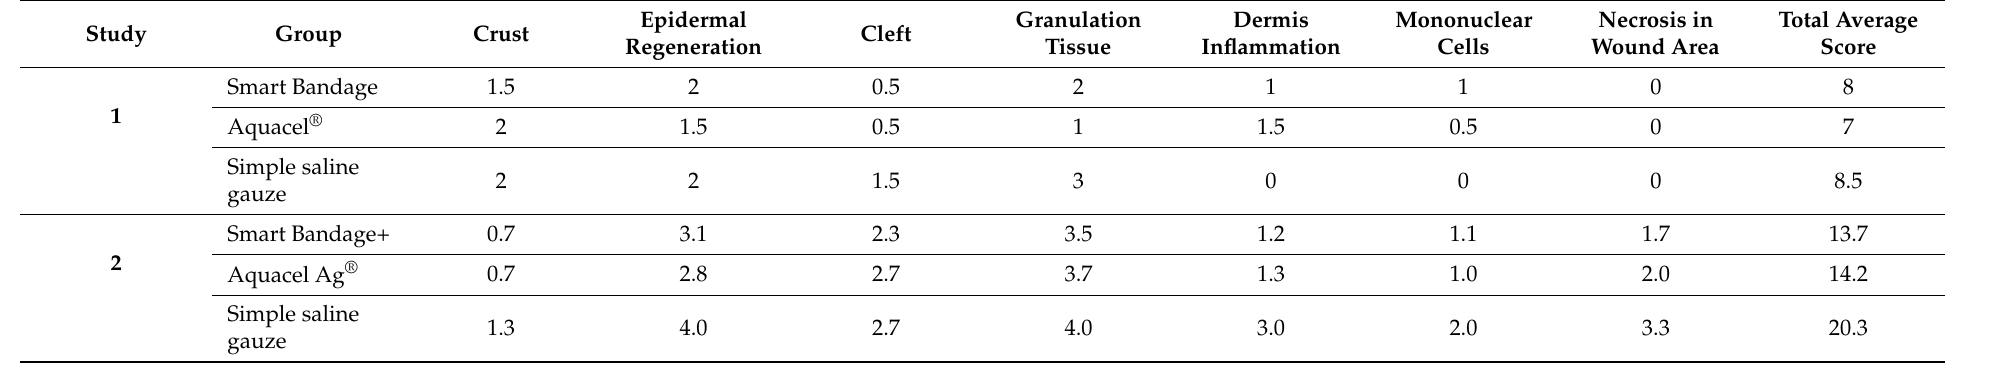
Table A3. Average scoring of histological parameters based on Tables A1 and